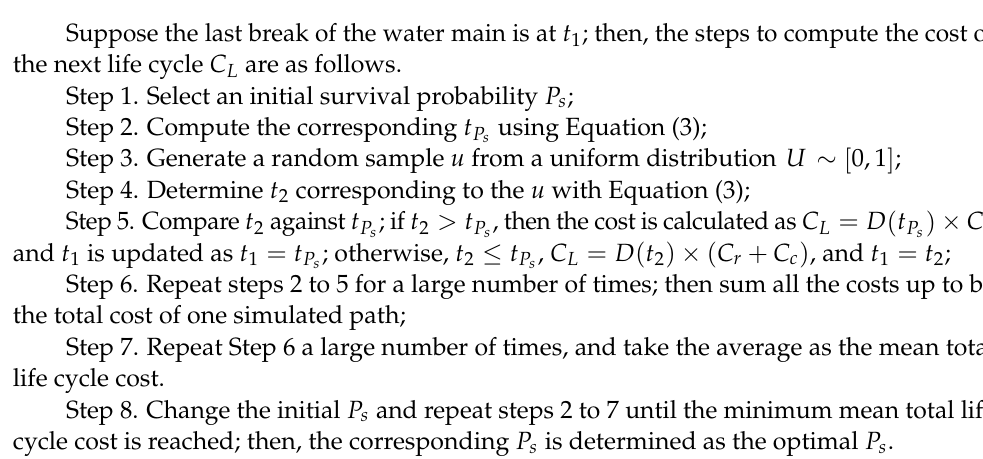
Figure 4. Illustration of the preventive strategy in terms of survival probability.